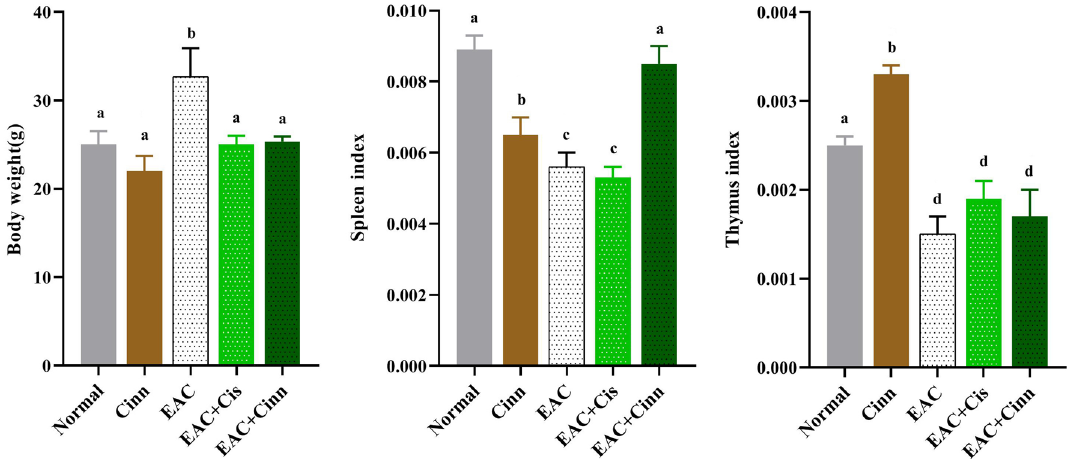
Figure 6. Changes in body weight, spleen and thymus indices following treatment with cinnamon essential oil (Cinn, 50 mg/kg b.wt/day, orally) revealing that Cinn essential oil partially succeeded to retrieve body weight, spleen and thymus indices to their normal values. All values were presented as Mean ± SD, ( n = 3). Significant differences ( P < 0.05) between groups were shown by different letters. Cis, cisplatin (2 mg/kg b.wt,